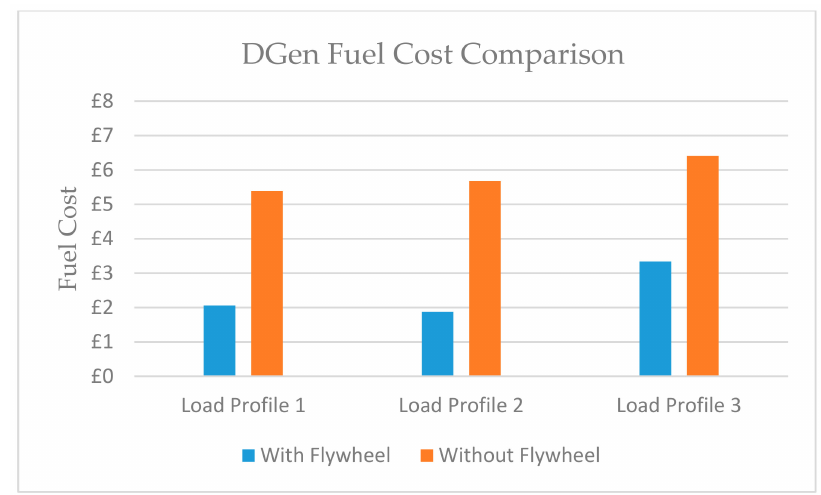
Figure 32. Fuel cost comparison of DGen with and without FESS.